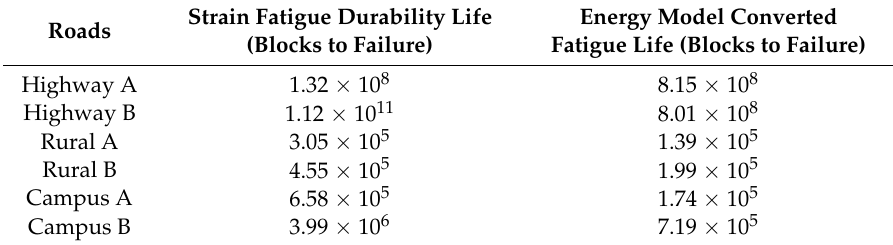
Table 5. Predicted SWT fatigue lives using measured and elastic-energy model converted